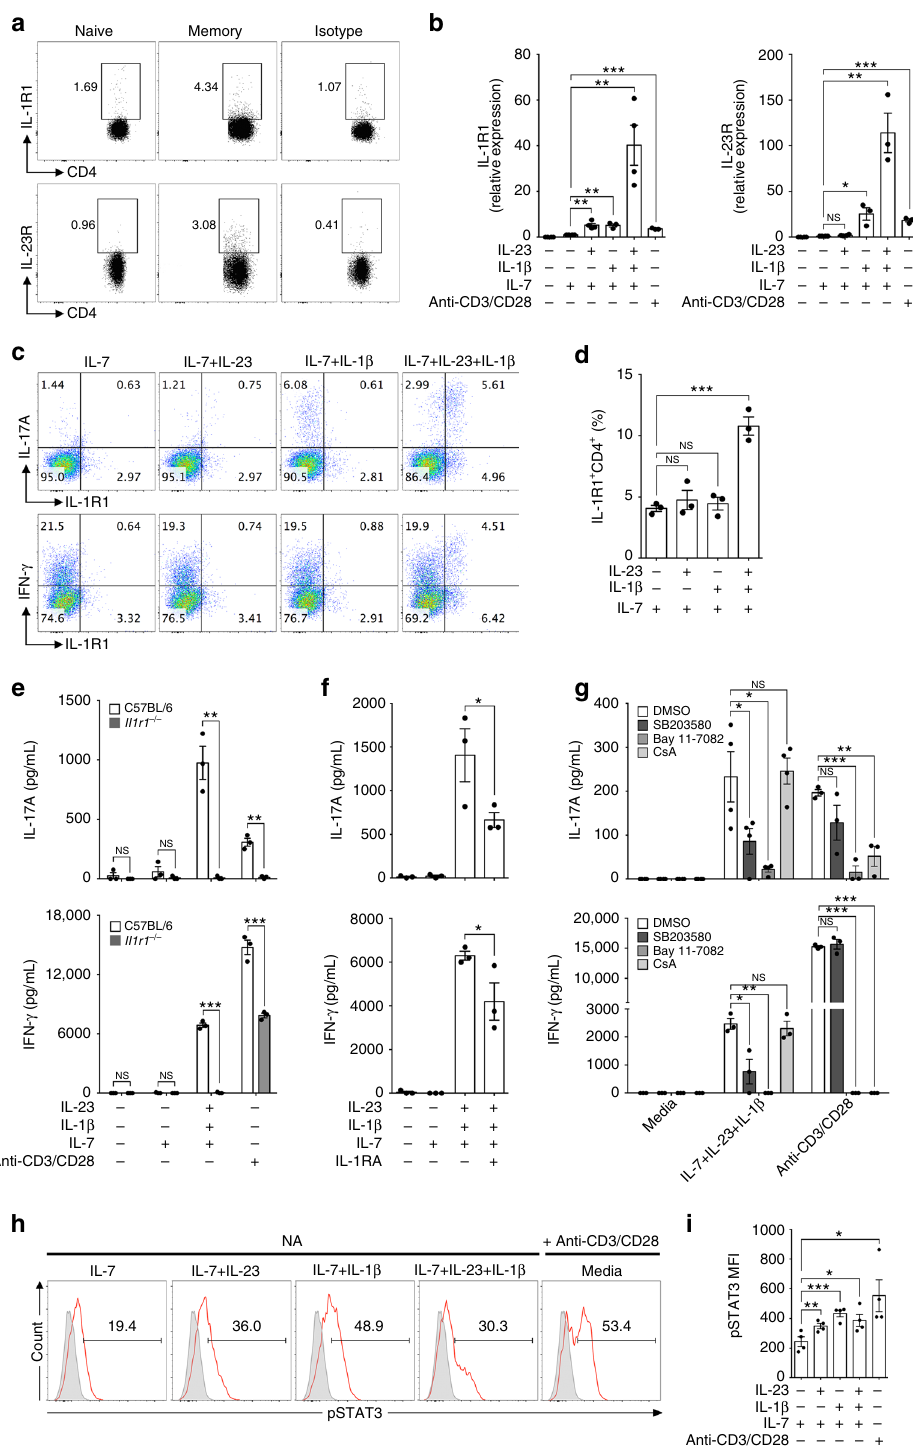
Fig. 2 Bystander activation of memory-like CD4 + T cells is dependent on IL-1 receptor signaling. a The basal expression level of IL-1R1 and IL-23R in naive (CD4 + CD62L high CD44 low ) and memory-like (CD4 + CD62L low CD44 high ) T cells was analyzed by fl ow cytometry. b Memory-like CD4 + T cells were stimulated with IL-1 β and/or IL-23 in the presence of IL-7 and the mRNA levels of IL-1R1 and IL-23R were analyzed by quantitative real-time PCR. c , d Memory-like CD4 + T cells were stimulated with IL-1 β and/or IL-23 in the presence of IL-7 for 5 days and the frequencies of IL-1R1, IL-17A, and IFN- γ were analyzed by fl ow cytometry. e Memory-like CD4 + T cells from C57BL/6 wild-type and IL-1R1-de fi cient ( Il1r1 -/- ) mice were stimulated with IL-1 β and IL-23 in the presence of IL-7 or anti-CD3/CD28 for 5 days, and IL-17A and IFN- γ concentrations in the supernatants were measured by ELISA. Memory-like CD4 + T cells were stimulated with IL-1 β and IL-23 in the presence or absence of f IL-1RA (IL-1R1 antagonist) or g SB203580 (p38 inhibitor), BAY 11-7082 (NF- κ b inhibitor), and CsA (Cyclosporin A) for 5 days. h , i phosphorylated STAT3 percentage and mean fl uorescence intensity were analyzed by fl ow cytometry. Data are presented as the mean ± SEM of at least three independent experiments. NS, not signi fi cant; * p < 0.05, ** p < 0.01, *** p <